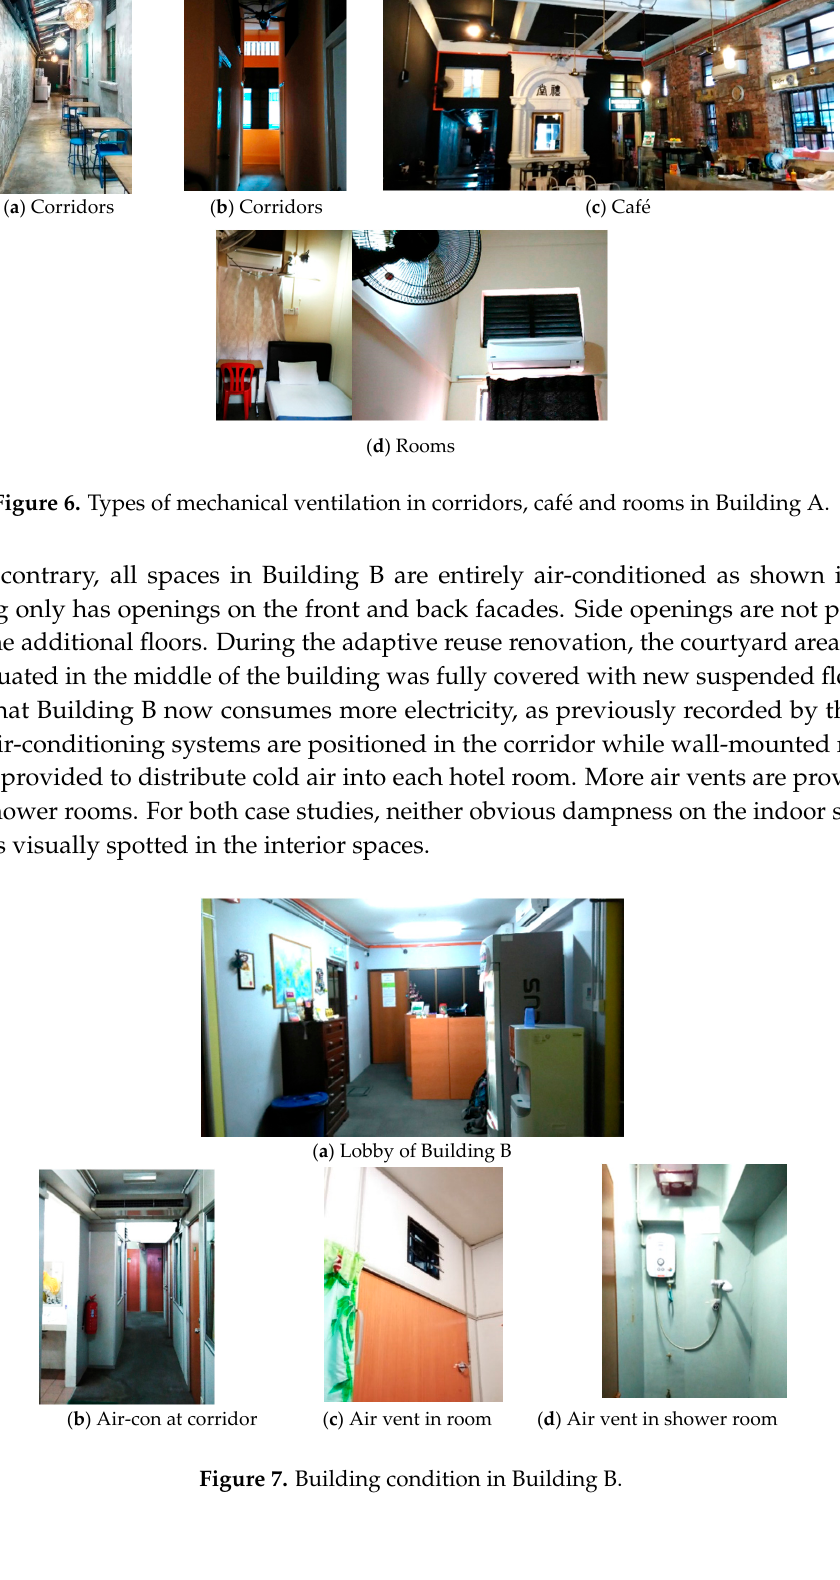
Figure 7. Building condition in Building B.